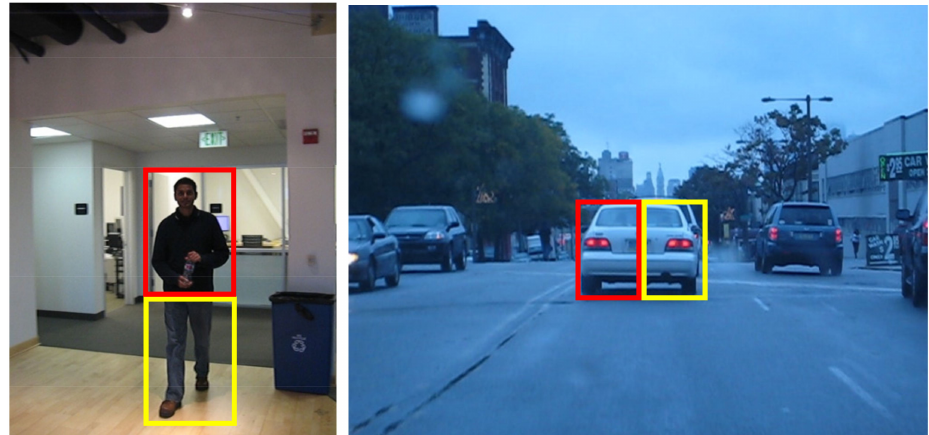
Figure 3. The way to divide the object when building two local filters. This layout is selected according to aspect ratio of the target object. Sequences are from Human2 and BlurCar1,